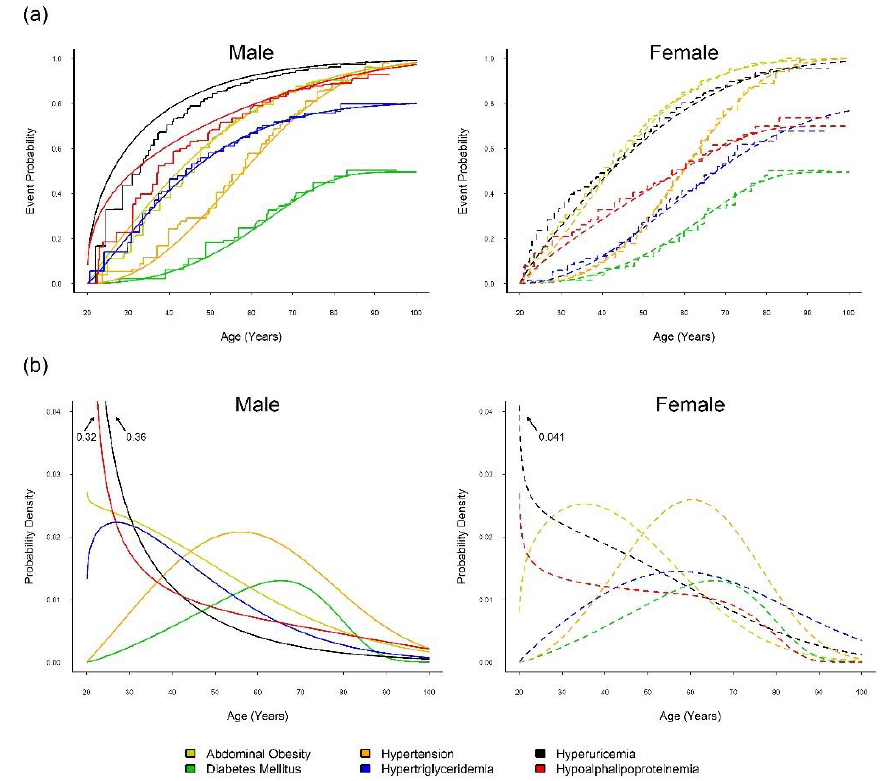
Figure 1. Time-to-event curves and probability density curves of five metabolic syndrome (MetS) components and hyperuricemia. ( a ) Smooth and step event time curves, and ( b ) probability density curves, of five MetS components and hyperuricemia for male (solid line) and female (dashed line), estimated from the optimally fitted models of the Cardiovascular Disease Risk Factors Two-Township Study (CVDFACTS) in Taiwan,